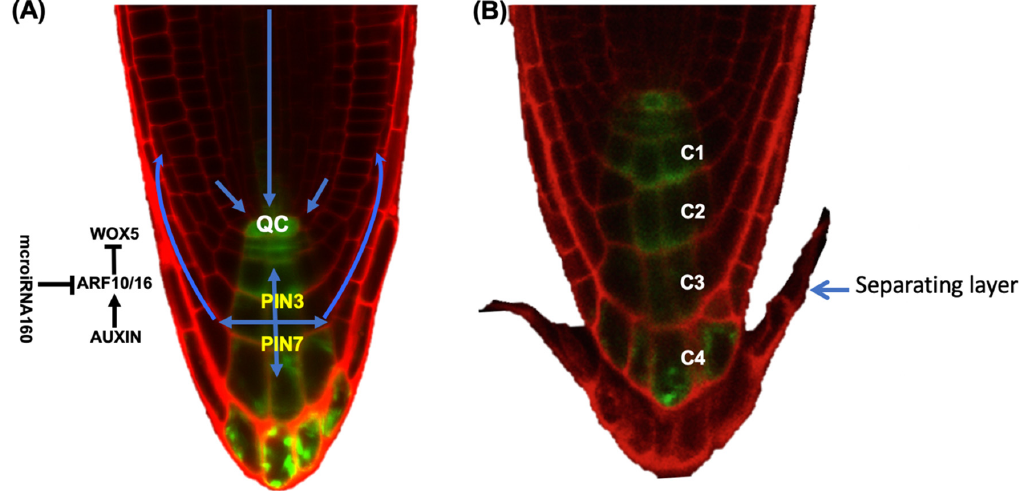
Figure 3. Auxin gradient in five-day old Arabidopsis root cap. ( A ) Columella localized PIN-FORMED (PIN) 3 and 7 and their flux direction. Auxin responsive factors (ARFs) 10/16 influence WOX5 to control columella cell differentiation and are regulated by auxin and miR160. Blue arrows indicate the direction of auxin flux. PIN3 and PIN7 are critical for auxin flux in the columella root cap, but additional PIN auxin transporters are required for flux in other cell types. Arrows and barred lines indicate positive and negative regulation, respectively. ( B ) The auxin response disappears from the separating layer. Auxin responsive synthetic promoter (pDR5:GFP) is used to show auxin response (green color). Columella (C) layers from C1 to C4. Arrows and barred lines indicate positive and negative regulations, respectively. Propidium iodide (red color) is used to visualize cells.